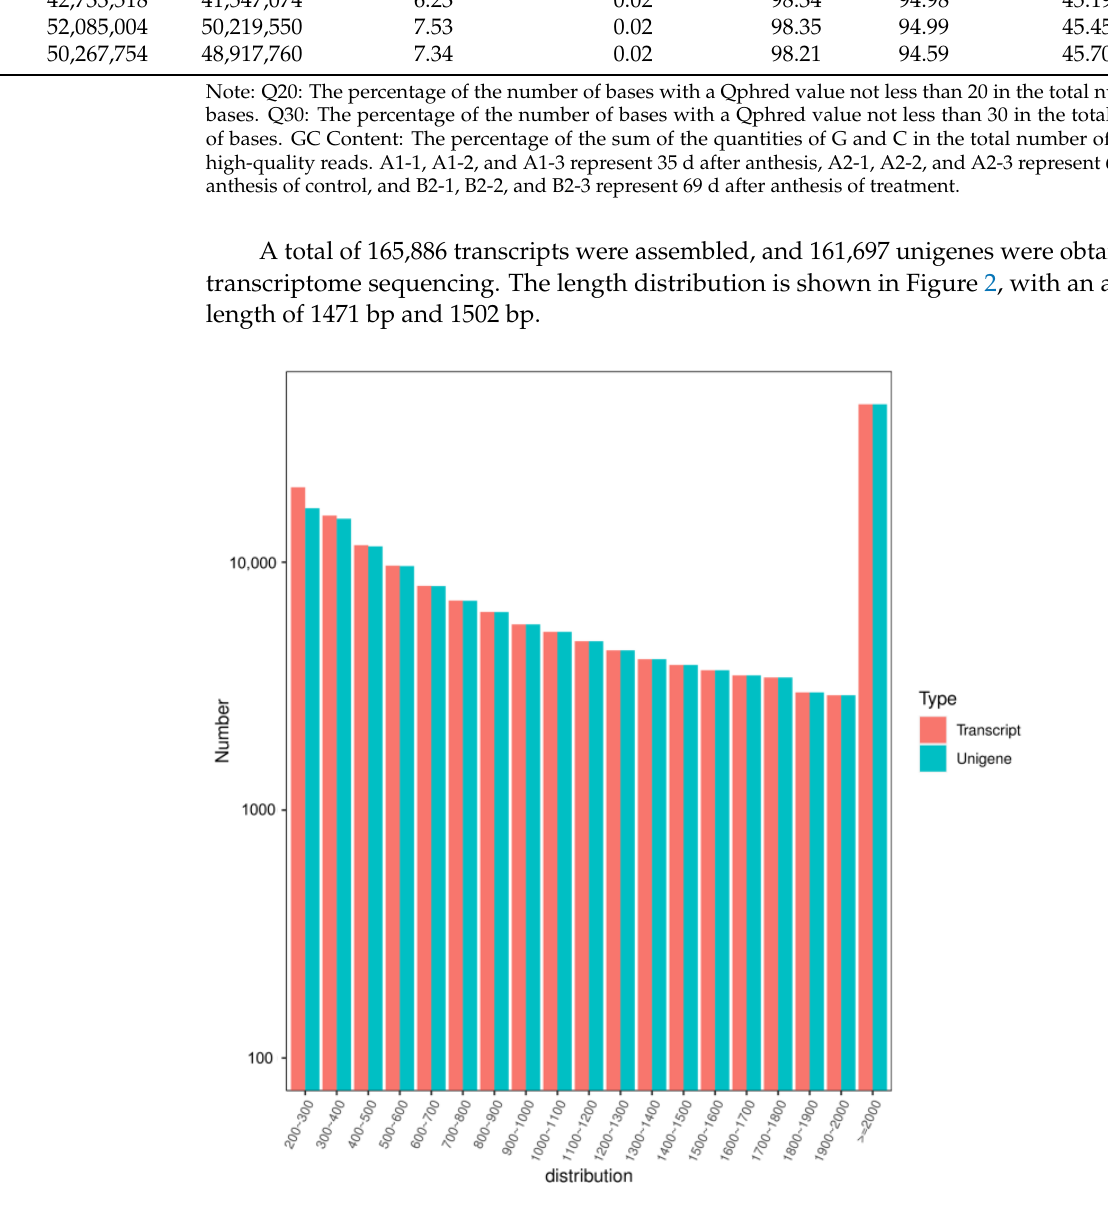
Table 2. Statistical results of transcriptome sequencing of ‘Feizixiao’ litchi pulp in 2020.